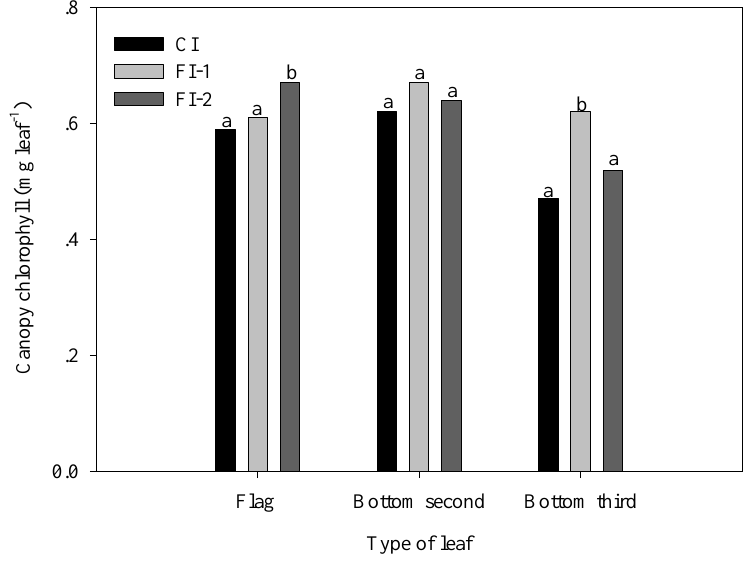
FIGURE 7. Comparisons of chlorophyll contents of canopy leaves among treatments. Different letters at the top of the bars indicate significant difference ( p <